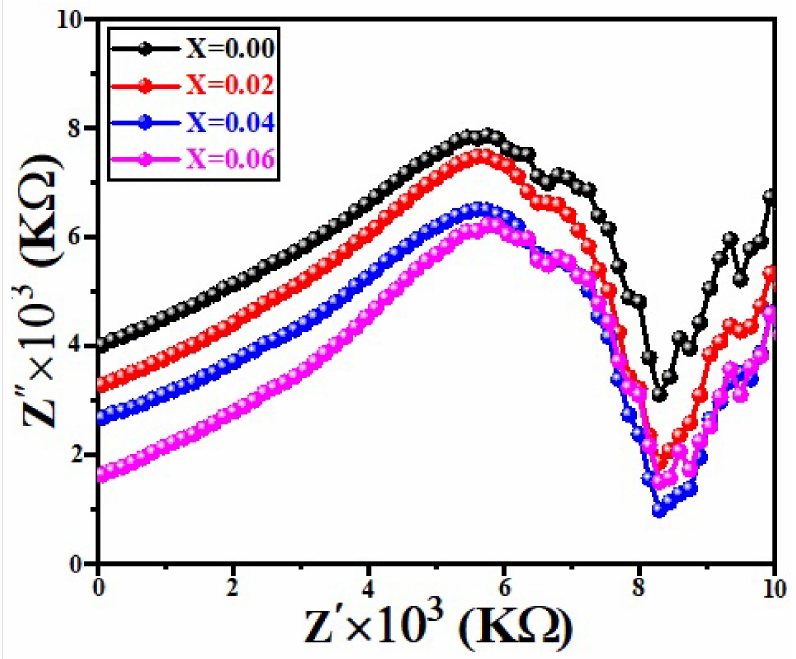
Figure 8. Cole-Cole Plots of (Sr 1 − x Ca x ) 5 Ti 4 O 13 , 0 ≤ x ≤ 0.06 sintered